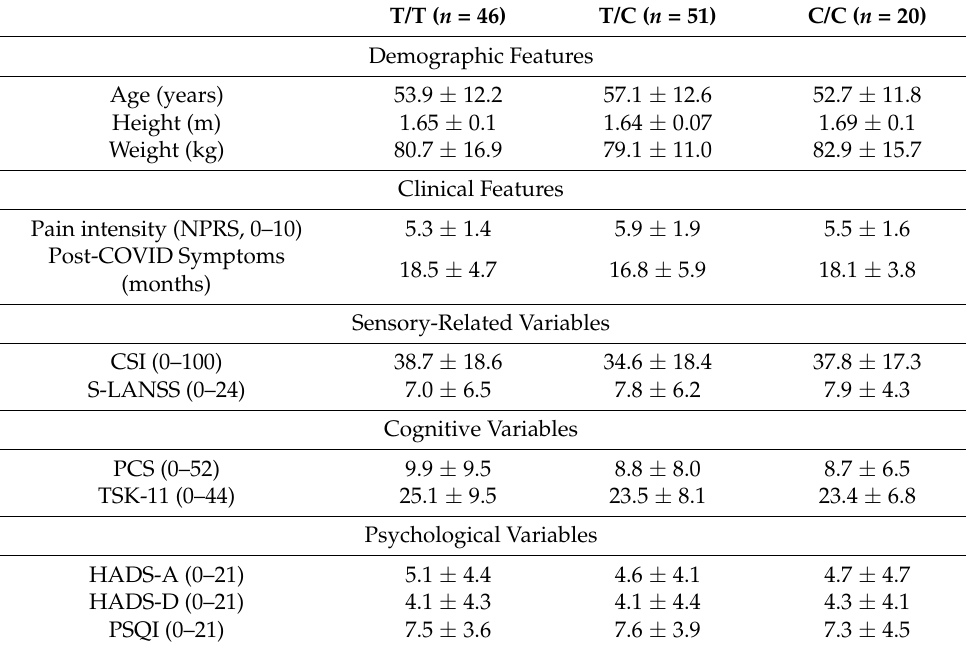
Table 3. Differences in pain phenotyping in COVID-19 survivors with post-COVID pain depending on the Interleukin-10 (IL-6) polymorphism (rs1800896).